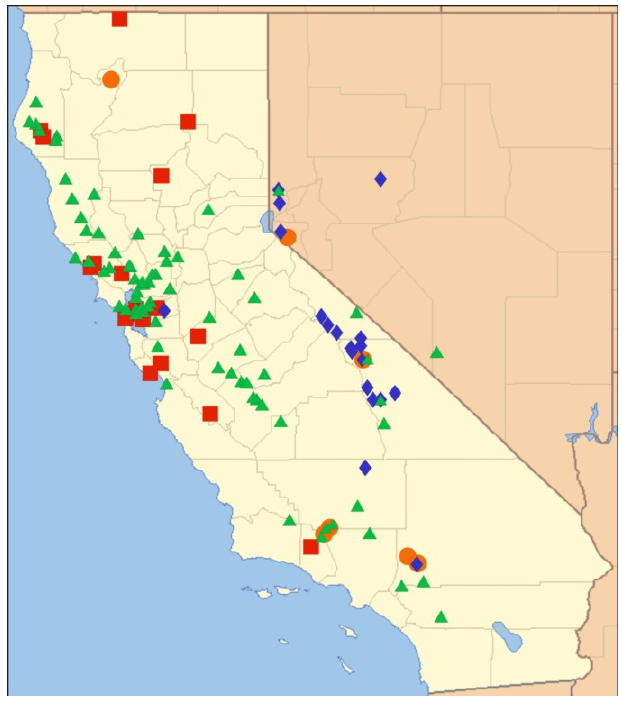
Figure 60. Distribution of Okanagana triangulata (green diamonds), O. sperata (orange circles), O. canescens (red squares) and O. aurora (blue diamonds).